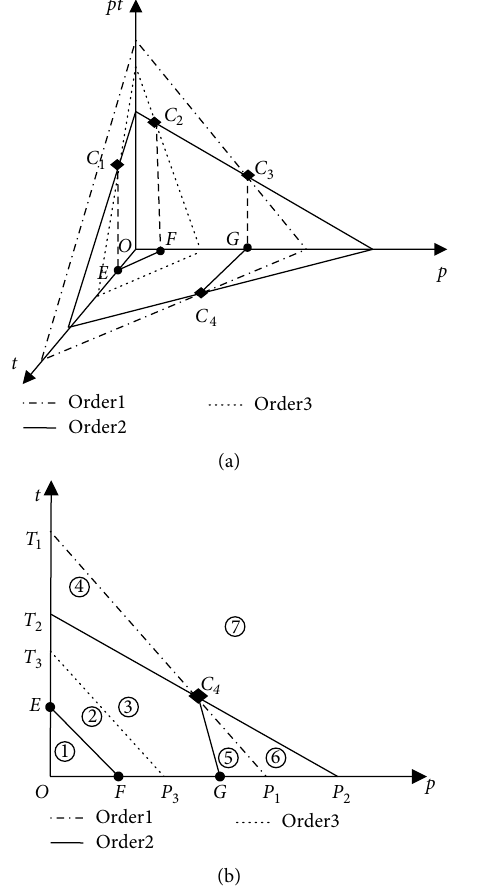
Figure 3: Order processing time function in general